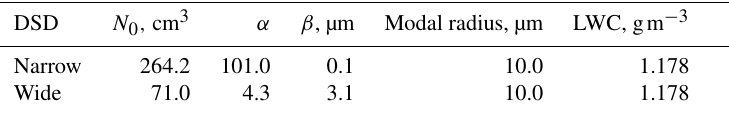
Table 1. Parameters of the initial gamma distributions.